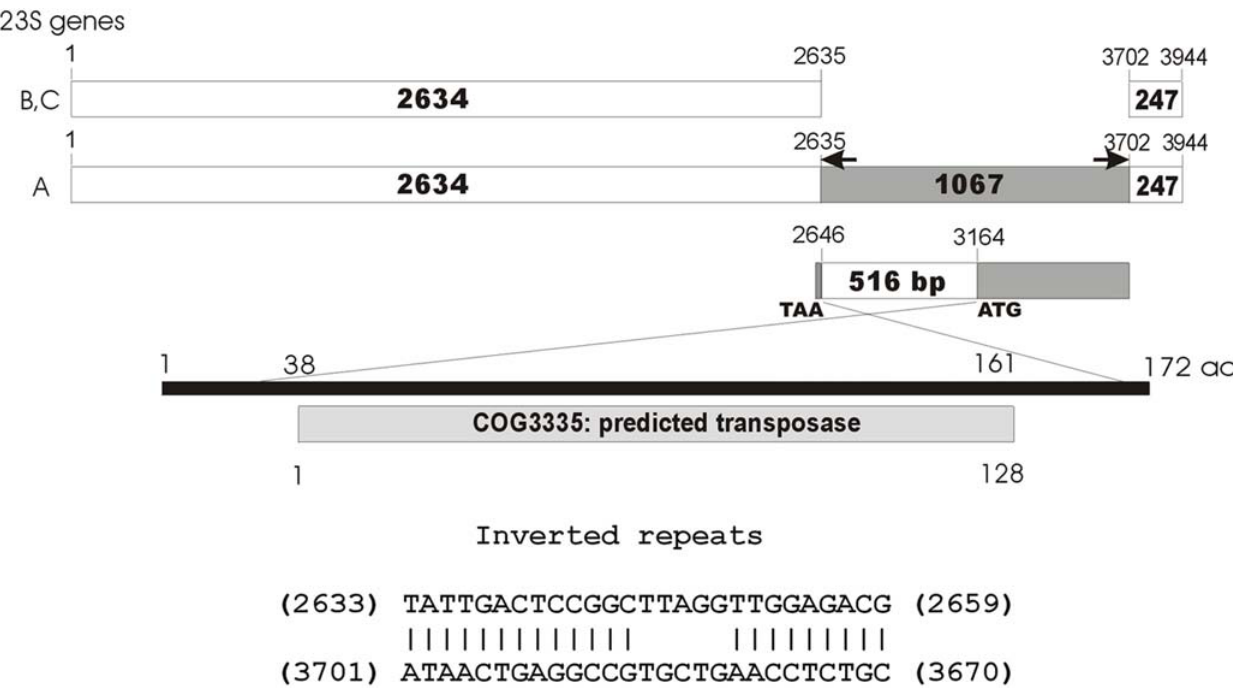
Figure 4. IVS in Deinococcusradiodurans 23S rRNA genes. rrnA23S contains a 1067-bp IVS flanked by 27-bp inverted repeats. The arrows indicate the location of the inverted repeats. The 1067-bp insert contains a 516-bp open reading frame encoding a 172-amino acid protein with strong homology (Expected value=8e 2 14 ) to predicted transposase COG3335.